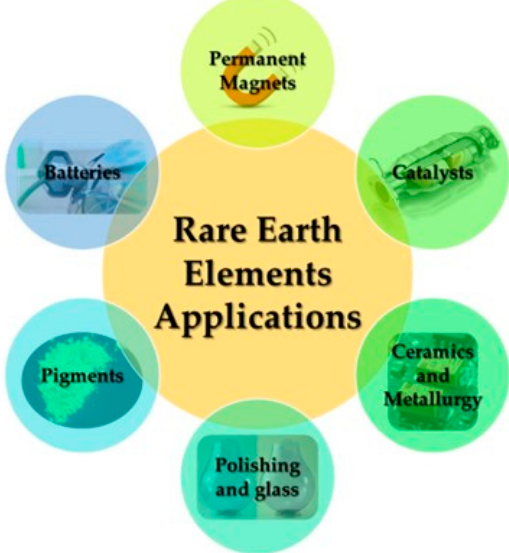
Figure 1. Main applications of Rare Earth Elements [18,19,23–25].